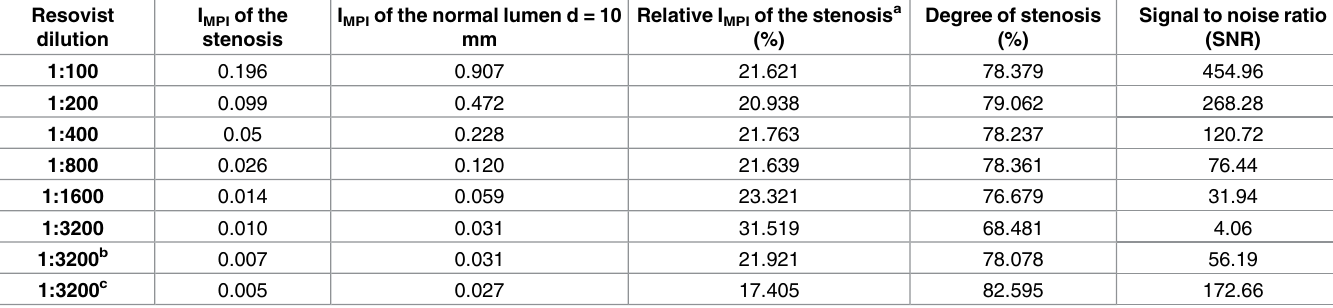
limits of agreement were -0.6% for the lower level of agreement (LLA) and 2.4% for the upper level of agreement (ULA). This means that in 95% of all MPI measurements, the measured degree of lumen loss will be at most 2.4% higher or 0.6% lower than the real degree of lumen loss. The positive bias indicates a slight underestimation of the lumen loss. For the stenosis phantoms, the mean difference was -2.9% stenosis (95% limits of agree- ment: LLA–ULA: -4.24%– 0.05%). These values suggest a slight overestimation of the extent of the stenosis. This effect seems to get less pronounced with higher degrees of stenosis. This Table 2. Serial dilution